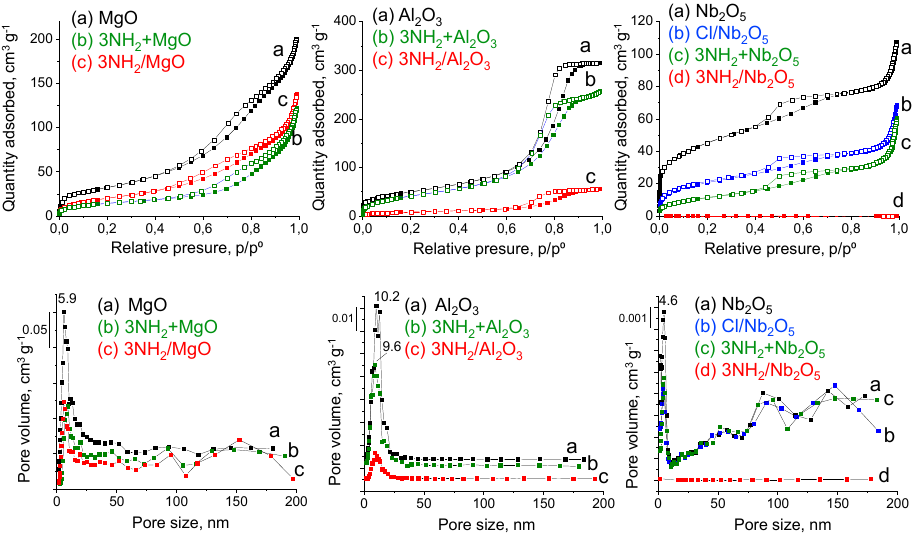
Figure 2. Nitrogen adsorption/desorption isotherms and pore size distribution for metal oxides before and after modification with tris(2-aminoethyl)amine.